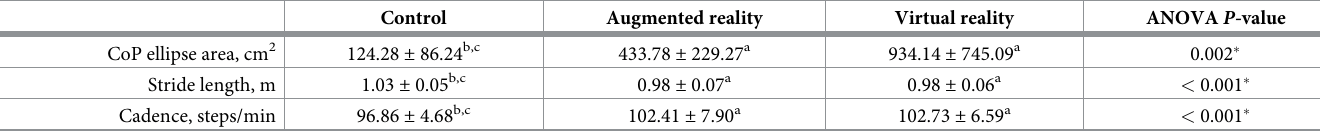
Table 1. Stride length, cadence and center of pressure ellipse area of different walking conditions.